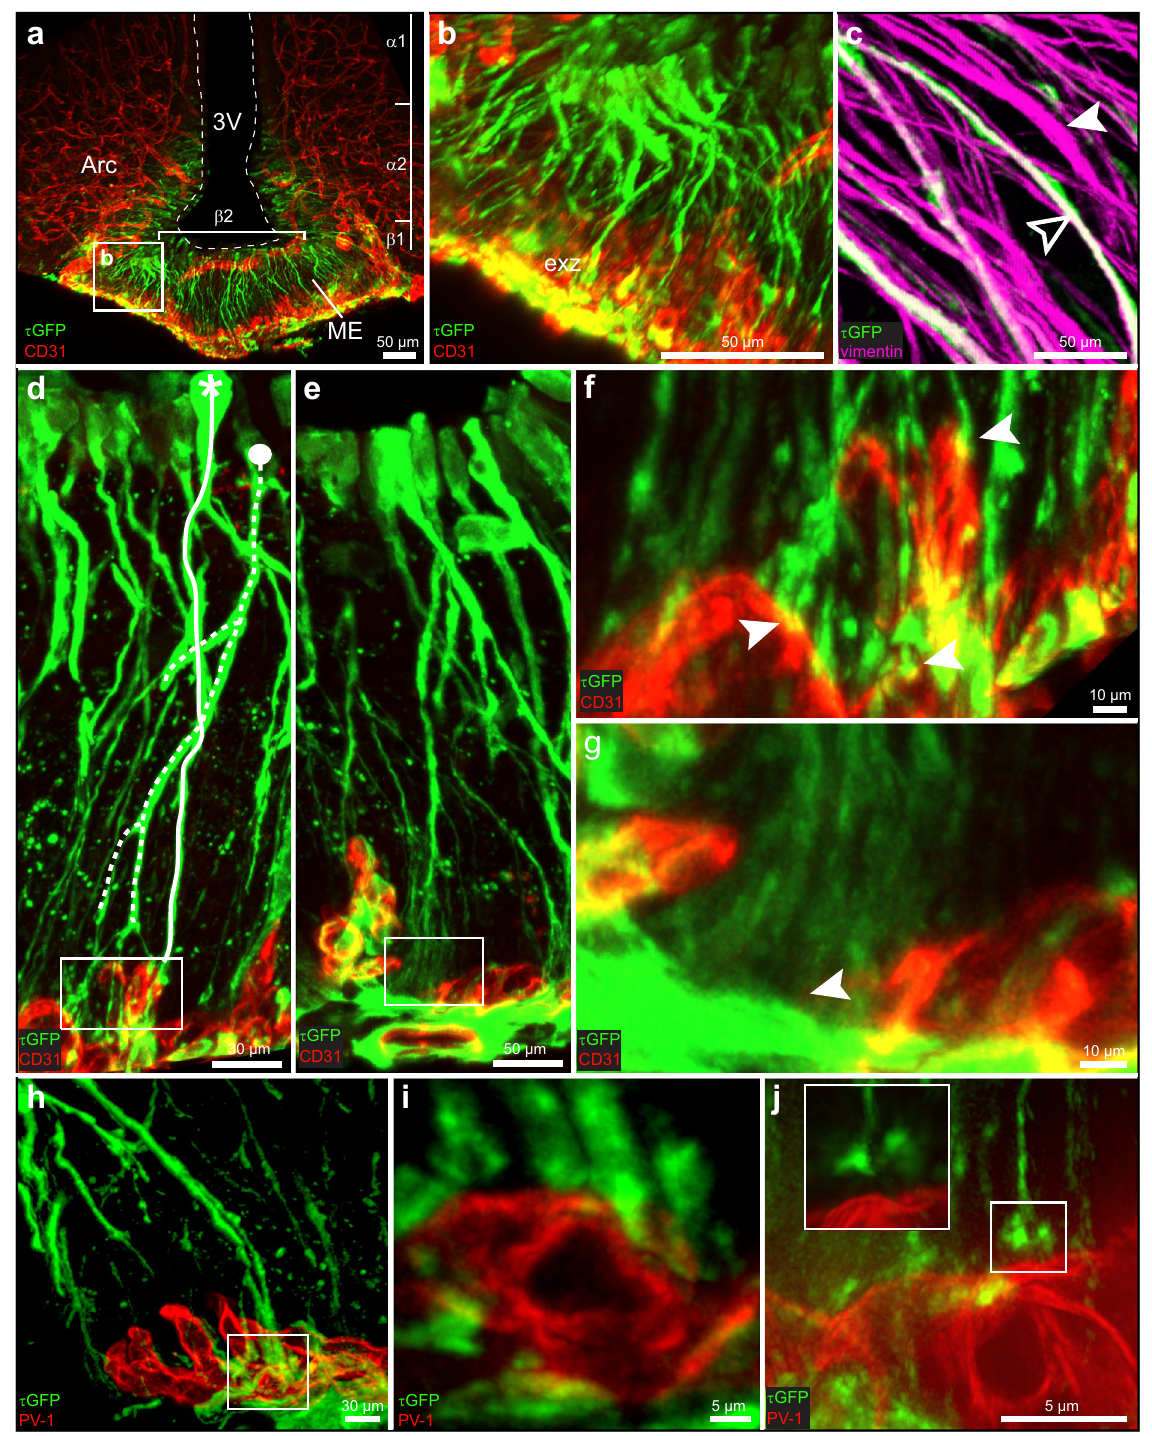
Fig. 1 | iDISCO-cleared and 3D-reconstructed images of the median eminence (ME) from M5-GFP mice immunolabeled for GFP (green, n =3), the vascular endothelial marker CD31 (red), the endothelial permeability marker PV-1 (red),orthetanycytemarkervimentin(magenta).a M5tanycytesarelocatedin the fl oorofthethirdventricle(3V)attheleveloftheventromedialarcuatenucleus (Arc) and ME. Tanycytic subpopulations based on previous classi fi cations are indicated. b Enlarged from the box in a , shows the elongated morphology of the M5 tanycytes projecting to the ME external zone (exz) near the capillary vessels. c Not all vimentin-positive pro fi les (magenta) are simultaneously GFP-labeled ( fi l- led arrowheads), demonstrating that TRMP5 expression delineates a speci fi c